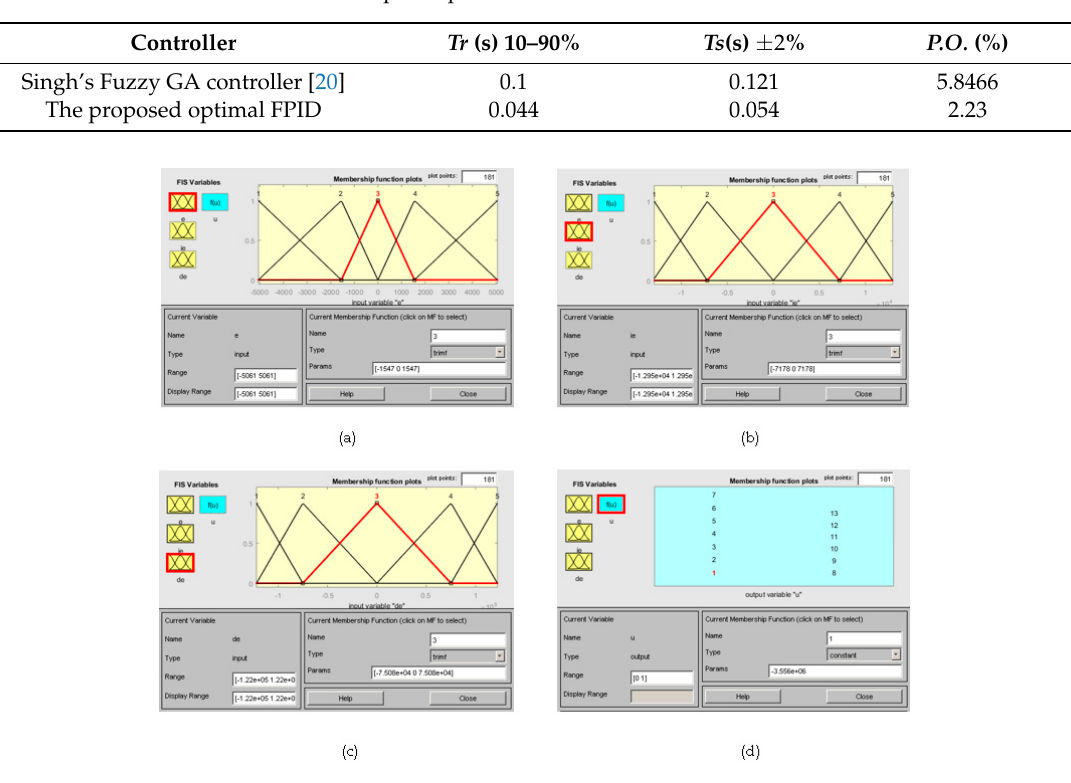
Figure 15. Membership functions for fuzzy variables: ( a ) e ( t ) ; ( b )